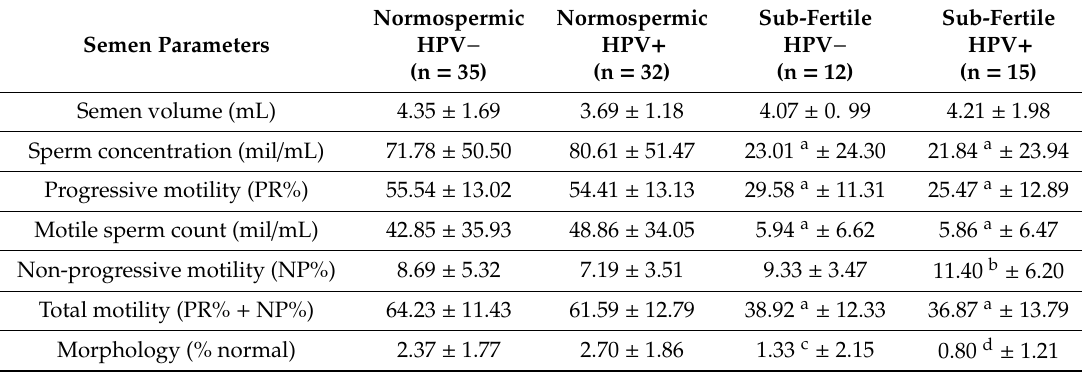
Table 1. Semen parameters of normospermic and sub-fertile patients with ( + HPV) and without HPV ( − HPV)